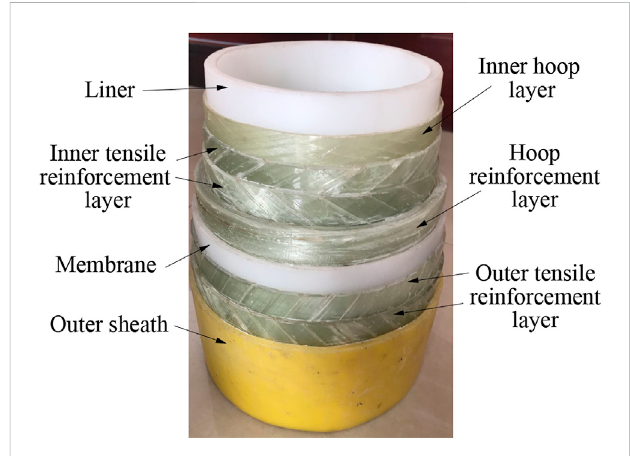
FIGURE 1 Fibre reinforced unbonded fl exible pipe with an inner diameter of